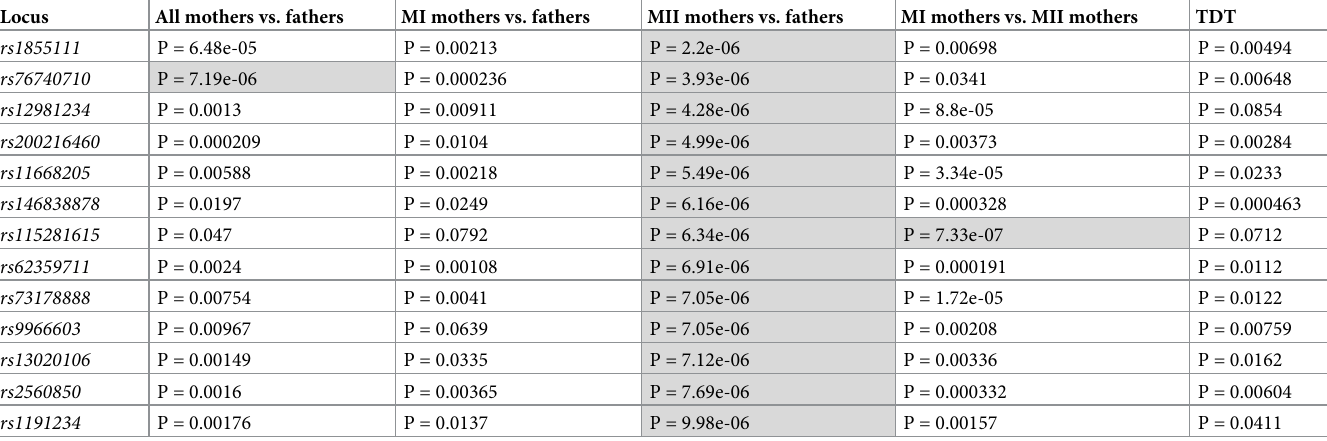
Table 5. Top hits from the MII mothers vs. fathers genome-wide association study. Locus All mothers vs. fathers